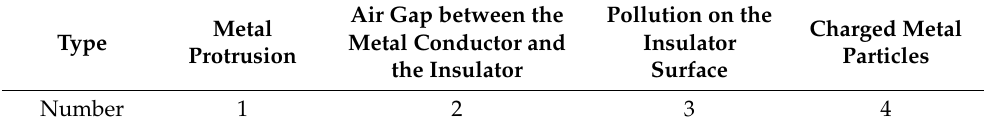
Table 2. Numbering of four defect